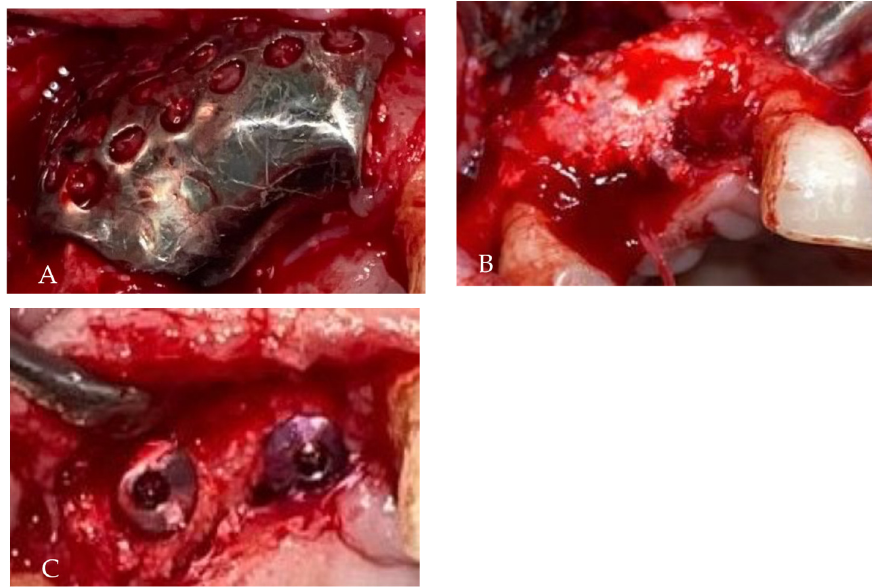
Figure 10. Intraoral findings: ( A ) aspect of the titanium mesh after flap elevation, ( B ) aspect of the